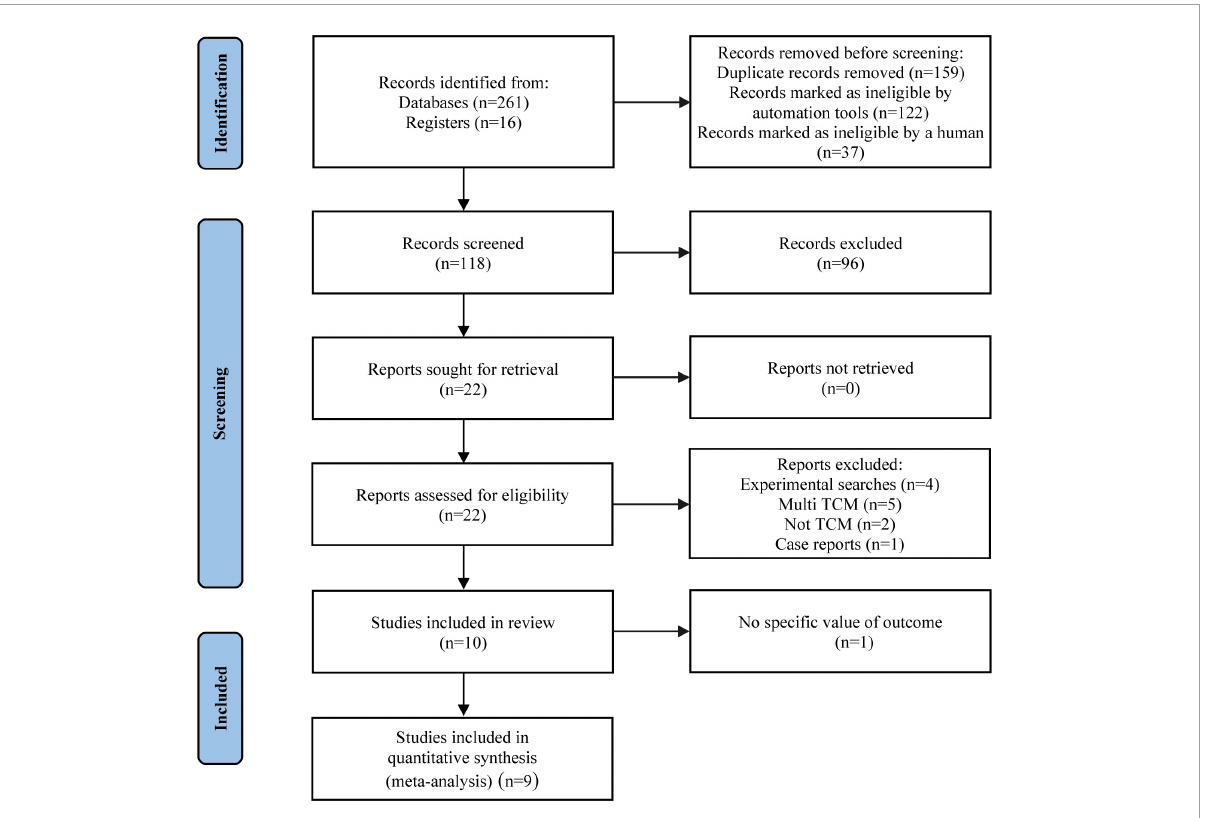
FIGURE1 PRISMA flow diagram of study selection